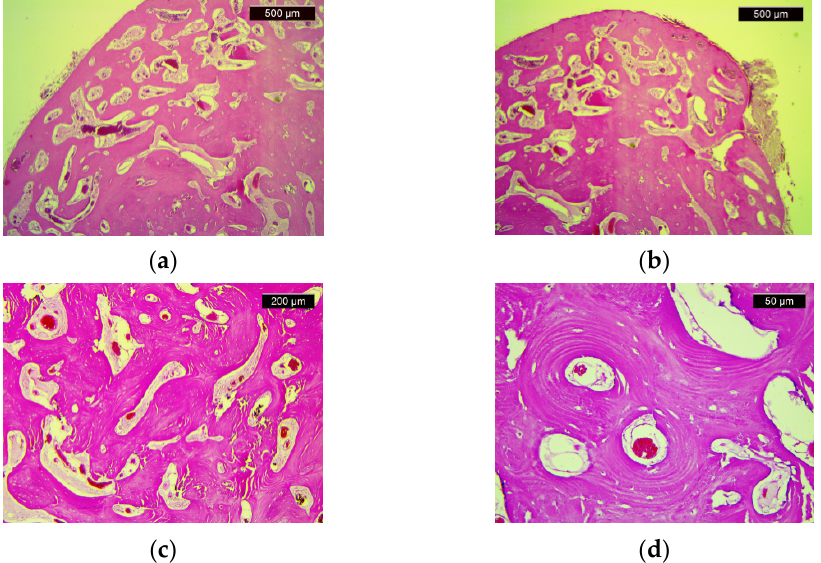
Figure 4. Histologic features of osteoma: ( a ) Dense cortical lamellar bone tissue (HE, ×25); ( b ) Dense, compact bone tissue with marked paucicellular and congestive stromal fibrosis (HE, ×25); ( c ) Com- pact, dense bone with visible Haversian canals (HE, ×50); ( d ) Haversian canals (HE, ×200).